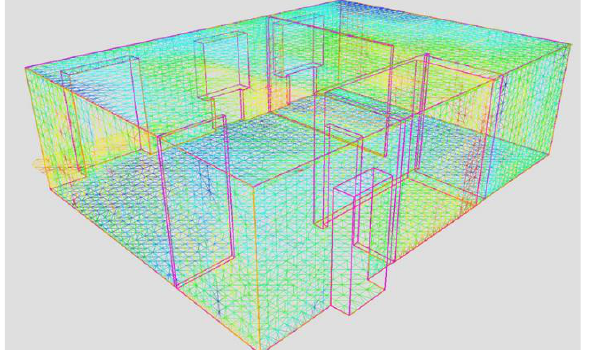
Figure 11 . 3D modeling of the interior.